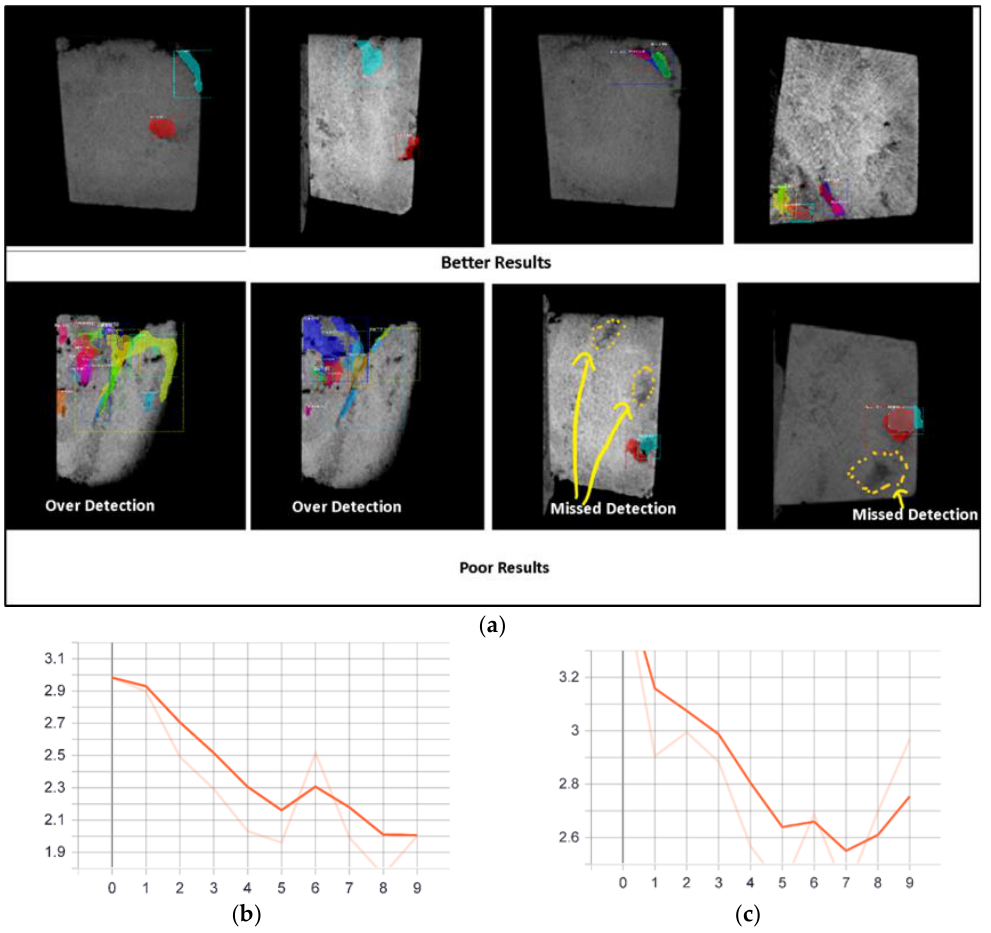
Figure 8. ( a ). Sample results with detected pores using deep learning mask RCNN. ( b ). Mask RCNN Train Loss by Epoch. ( c ). Mask RCNN Validation Loss by Epochs.